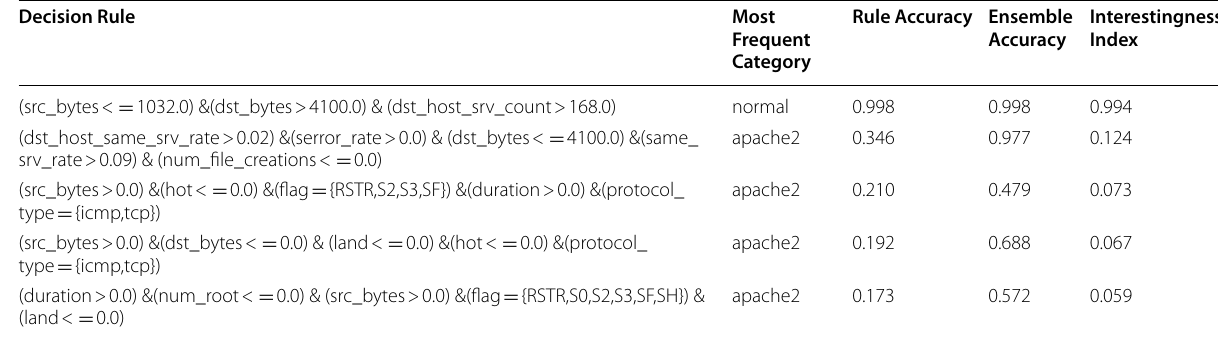
Table 2 Top Decision Rules for ’attack’ in RF model